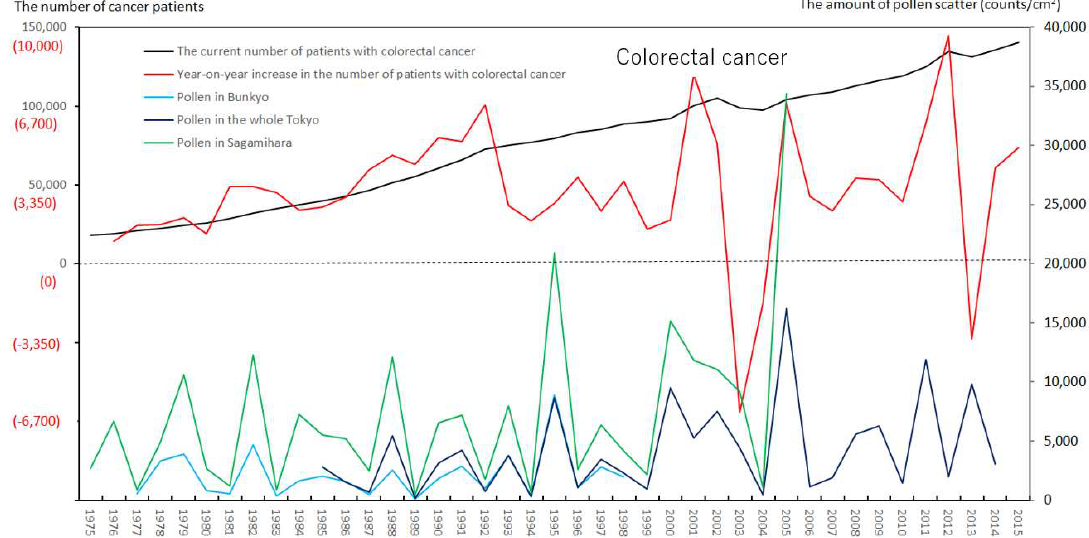
Figure 5. The current number of Japanese males and females (presently registered patients) registered for stomach cancer at the year diagnosed, its year-on-year increase (newly registered patients), and the amount of air borne pollen scatter in 3 areas during the period from 1975 to 2015. The line graphs for males and females with stomach cancer representing numbers of presently and newly registered patients in each year, as well as the amount of pollen scattered during the period from 1975 to 2015. No relationship was noted between phasic increments of newly registered patients and phasic increments of airborne pollen scatter.